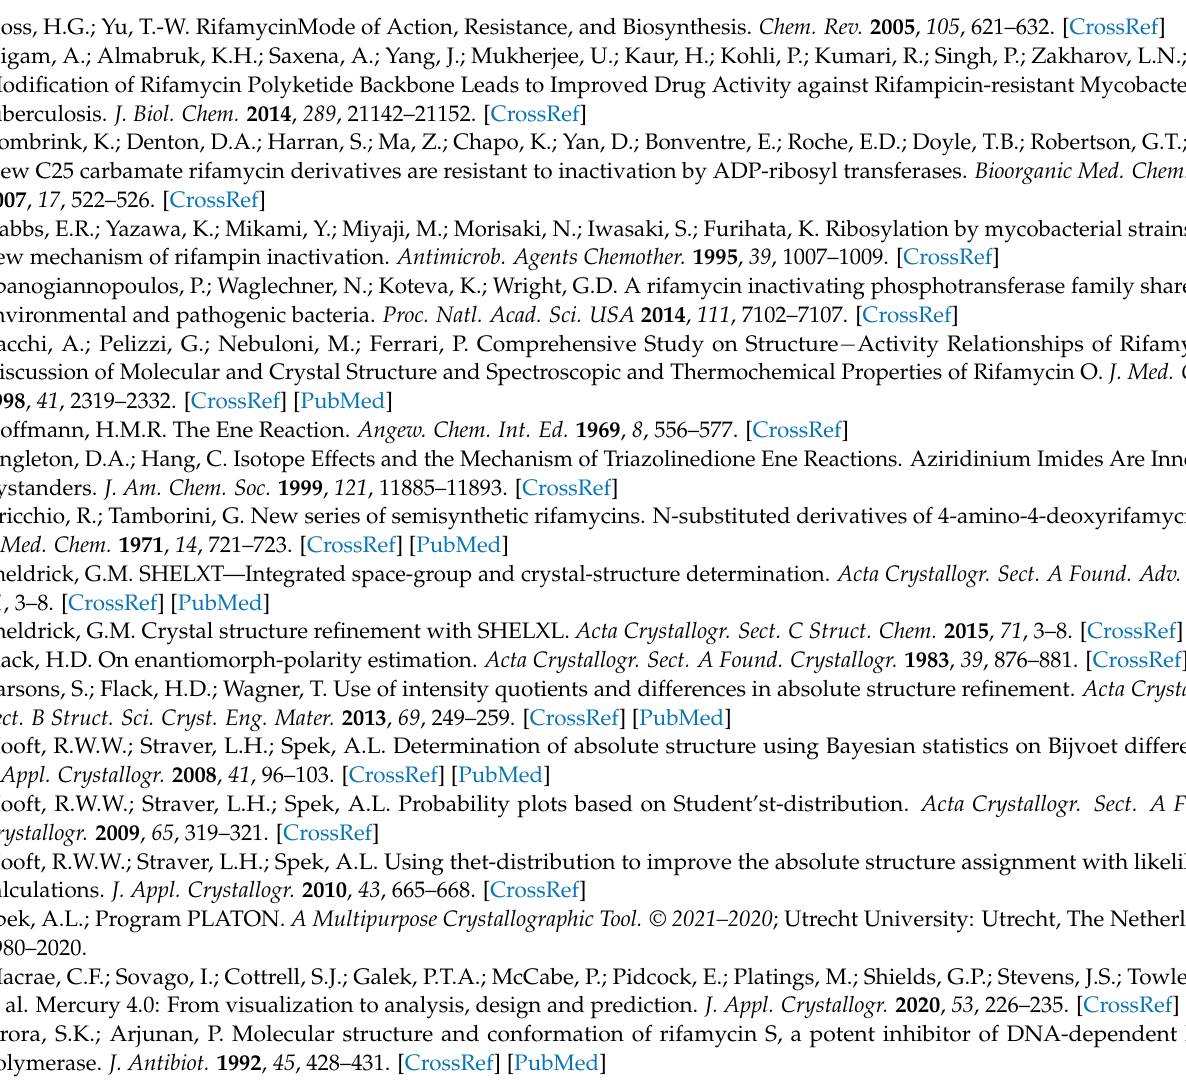
Figure S2: Structure overlay for compound 3 and Rifamycin S,